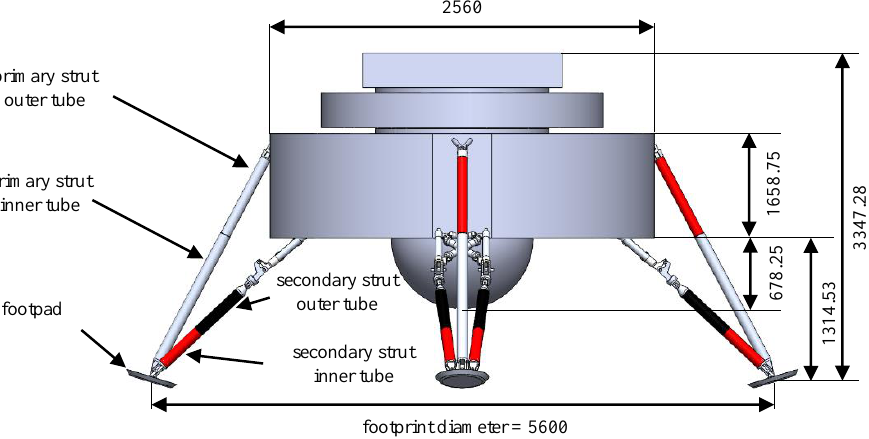
Figure 1. Lunar lander configuration, main parameters and deployed configuration. All dimensions in